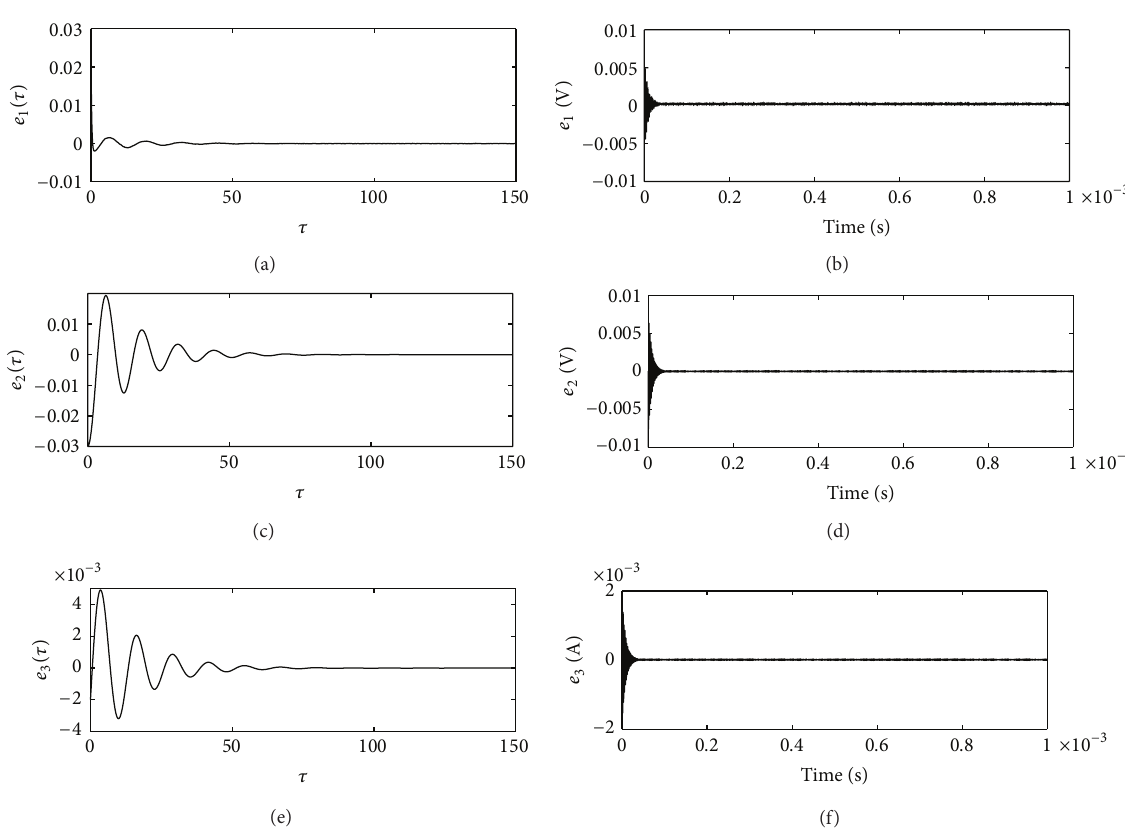
Figure 4: Time evolution of the synchronization errors from Matlab simulations (left) and Pspice simulations